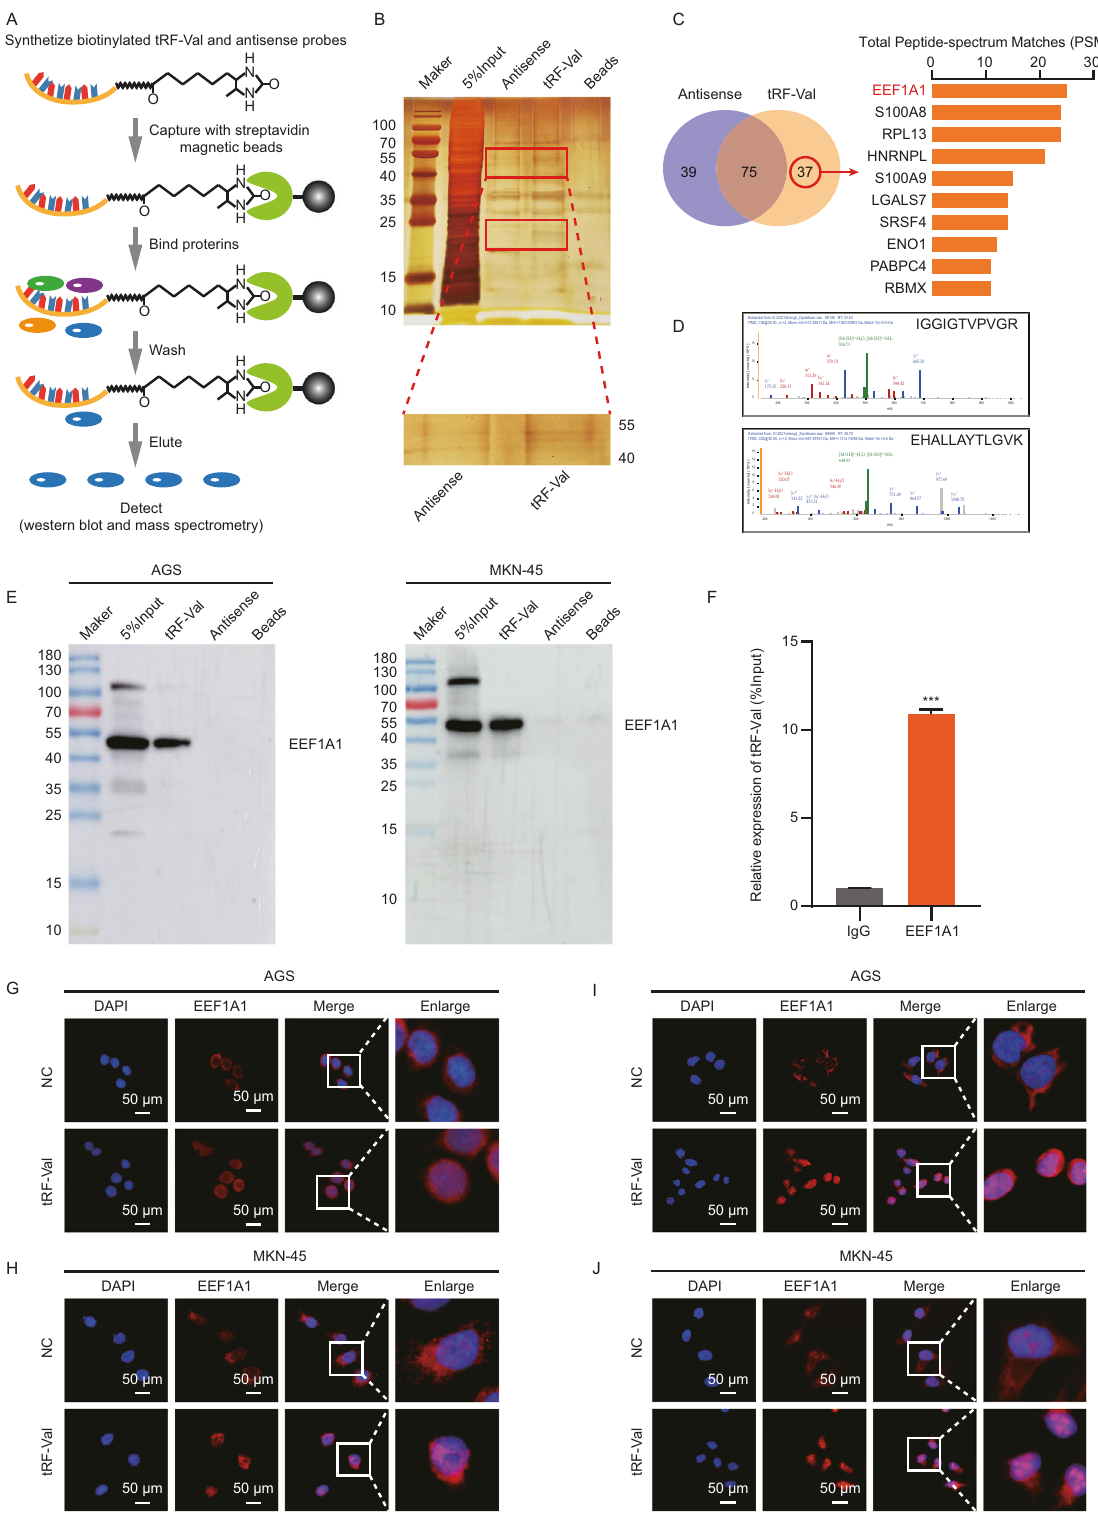
Fig. 4 tRF-Val directly binds to EEF1A1 protein and promotes its transport into nucleus. A The work fl ow of tRF-Val pulldown assay. B Silver staining assay was performed to detect the differential proteins obtained by the pulldown assay in AGS cells. C The top 10 proteins with the highest PSMs scoring identi fi ed by mass spectrometry were shown, and EEF1A1 was identi fi ed as a tRF-Val binding protein. D The two speci fi c peptides of EEF1A1 identi fi ed by mass spectrometry. E Independent RNA-pulldown assays and WB assays con fi rmed the interaction of tRF-Val and EEF1A1 in AGS and MKN-45 cells, respectively. F RIP assay was performed to detect the interaction of tRF-Val and EEF1A1 in AGS cells. G , H IF assay proved that tRF-Val signi fi cantly enhanced the fl uorescence of EEF1A1 in the nucleus of AGS and MKN-45 cells. The scale bar, 50 μ m. I , J FISH assay con fi rmed that tRF-Val overexpression mainly enhanced its fl uorescence in the nucleus. The scale bar, 50 μ m. Data were shown as mean ± SD. (Student ’ s t -test, *** P < 0.001). PSMs means peptide-spectrum